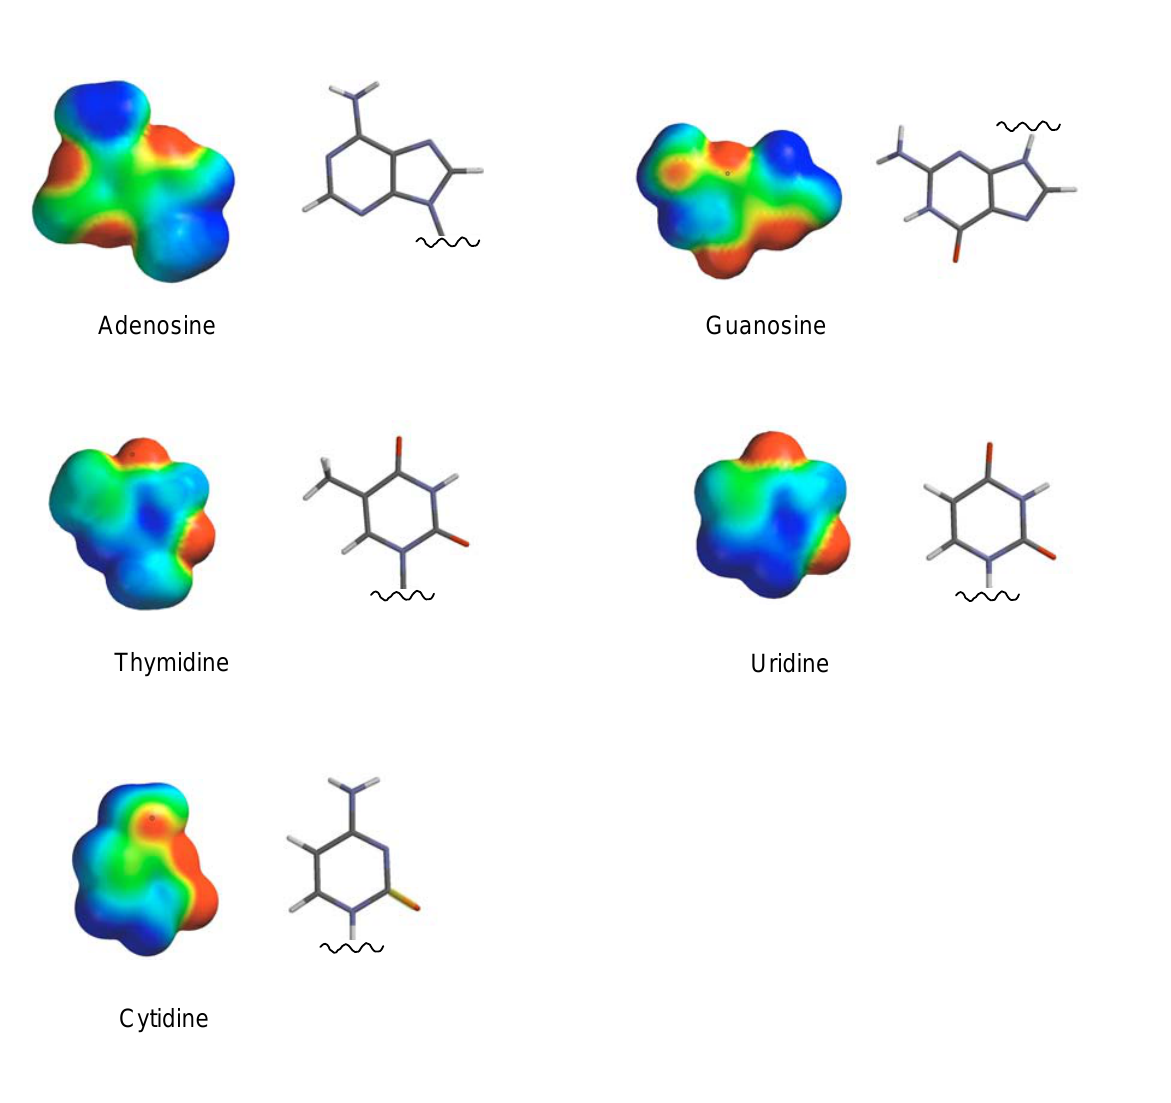
Figure 3. Electrostatic Potential Surface (EPS) of the nucleic bases calculated with PM3 showing the varying distribution of electron density on their respective π -faces (EPS color code: - 25 kcal/mol: red; + 25 kcal/mol: